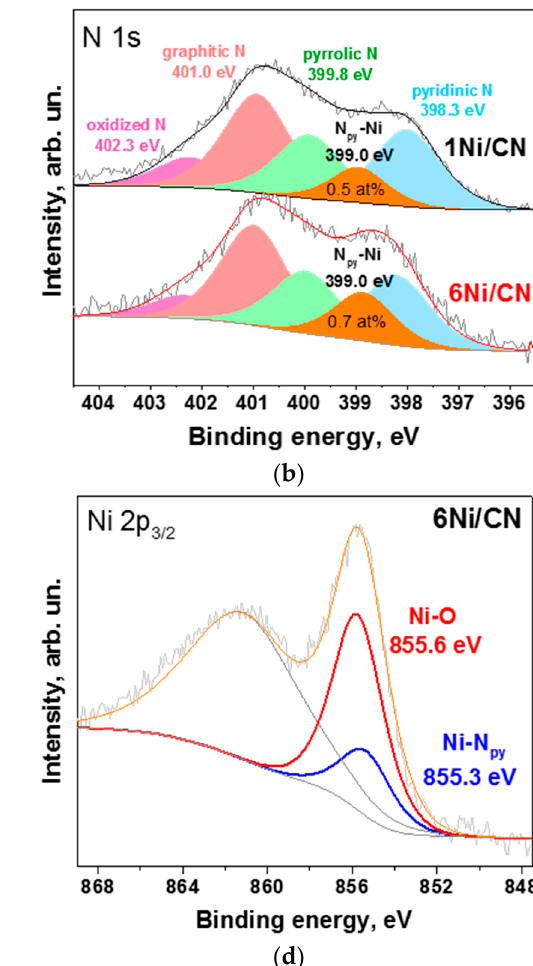
Table 2. The XPS-derived surface concentration of the main elements in 6Ni/CN and 6Ni/C. Sample Ni, at% C, at% N, at% O, at% 6Ni/C 0.10 ± 0.01 94.3 ± 4.7 8.5 ± 0.4 A direct comparison of the N 1s spectra of the initial 1Ni/CN sample and the 6Ni/CN sample shows an increase in the intensity of the latter spectrum at ~399 eV (Figure 4a). The N 1s spectra of both samples are fitted by five components (Figure 4b), corresponding to pyridinic N (N py , 398.3 eV), N py -Ni bonds (399 eV), pyrrolic N (399.8 eV), graphitic N (401.0 eV) and oxidized N species (402.3 eV) [26,32]. An analysis of the N 1s spectra gives the content of nitrogen involved in the N py -Ni bonds as ~0.5 at% for 1Ni/CN and ~0.7 at% for 6Ni/CN. Thus, for the 6Ni/CN sample, the fraction of N py -Ni species is 24%, which agrees well with the EXAFS fitting data (30% in Table 1).